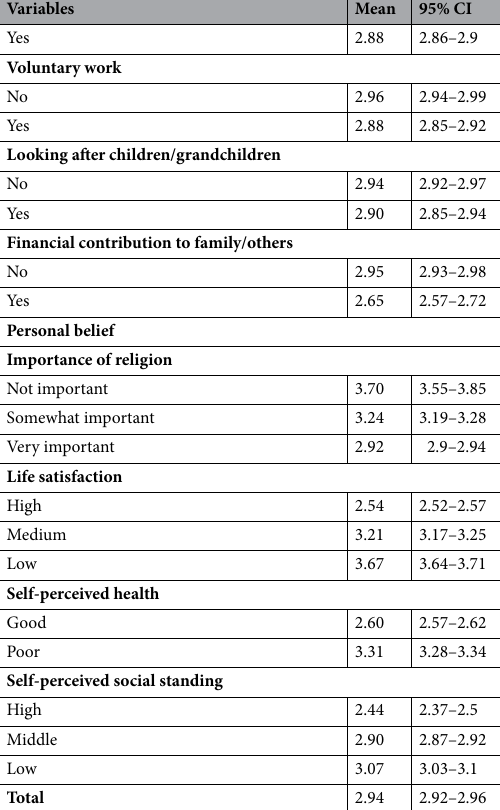
Table 2. Mean CES-D score among older adults by background characteristics, 2017–18. CI Confidence